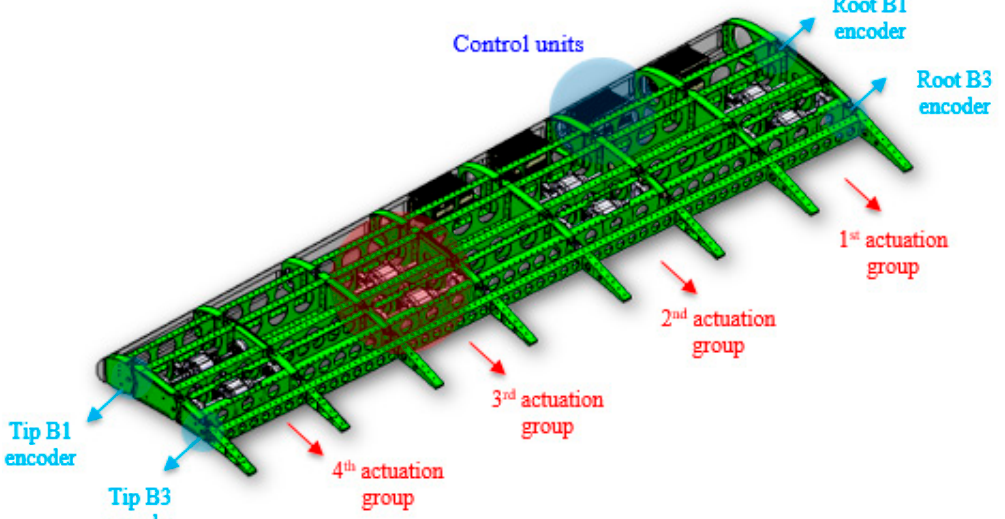
Figure 5. Bi ‐ modal morphing flap layout: skeleton and systems (hidden skin).